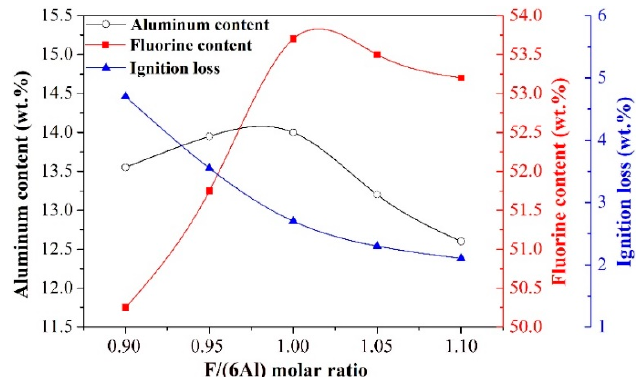
Figure 12. Effect of F/(6Al) molar ratio on the aluminum content, fluorine content and ignition loss of synthetic cryolite.